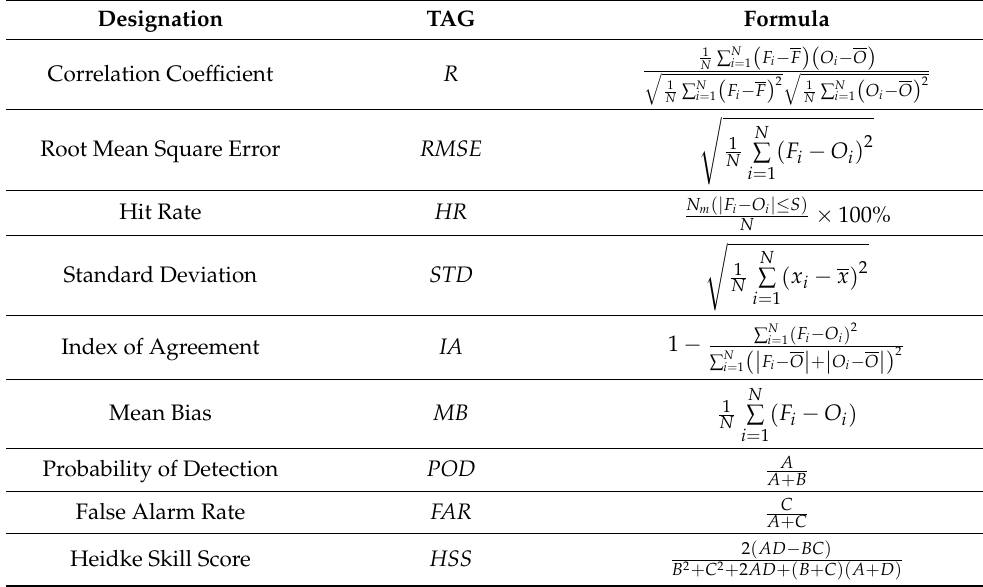
Table 2. The formulae of standard statistical indices employed in this study. Designation TAG